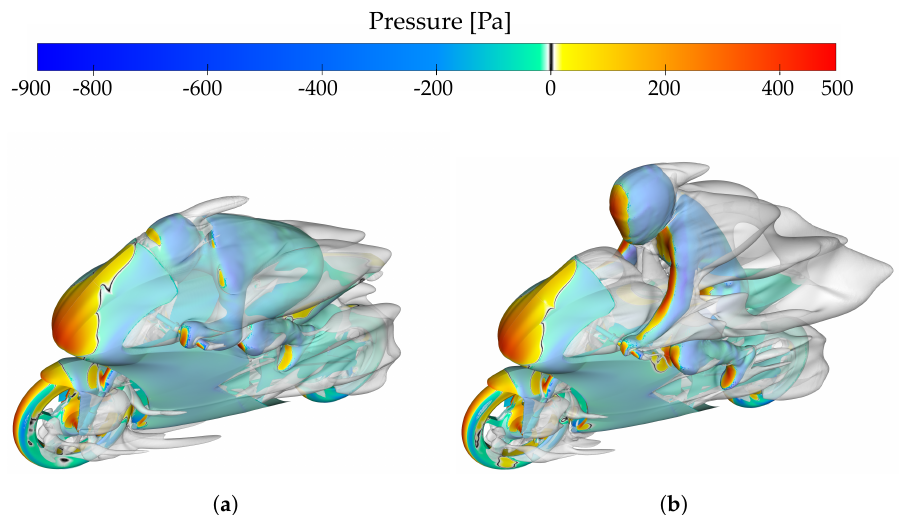
Figure 23. Contours of static pressure on motorbike and rider and iso-surface of total pressure equal to zero for rider in ( a ) low-drag position and ( b ) upright rider.